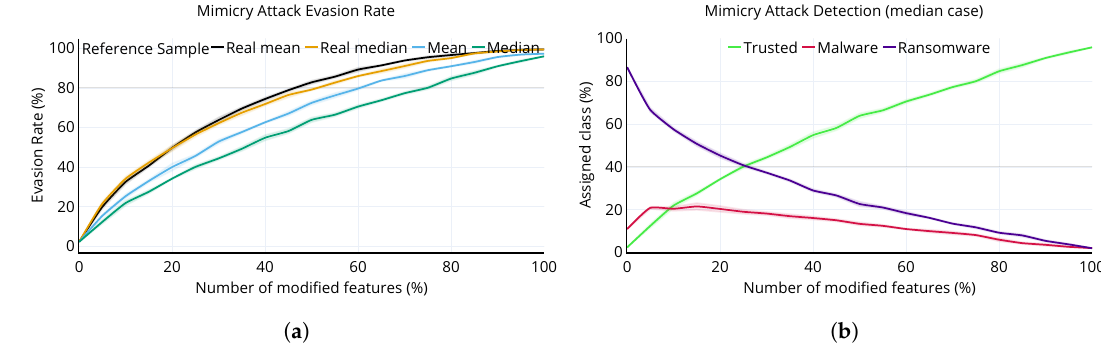
Figure 8. Mimicry attack’s evasion rate for different choices of the reference sample ( a ). Detection rate detail of the ransomware samples ( b ). Both figures are the average results over five repetitions and include the standard deviation in translucent